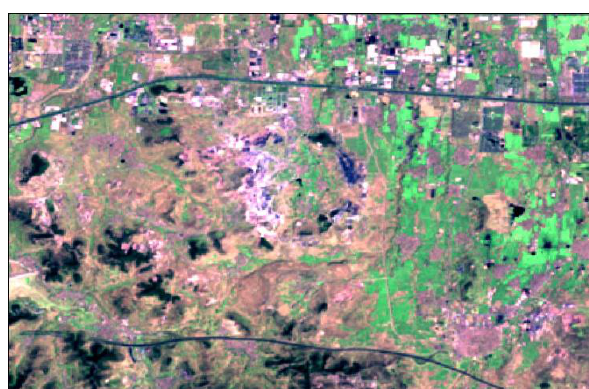
Figure 2. Ring-shaped structure on the TM image